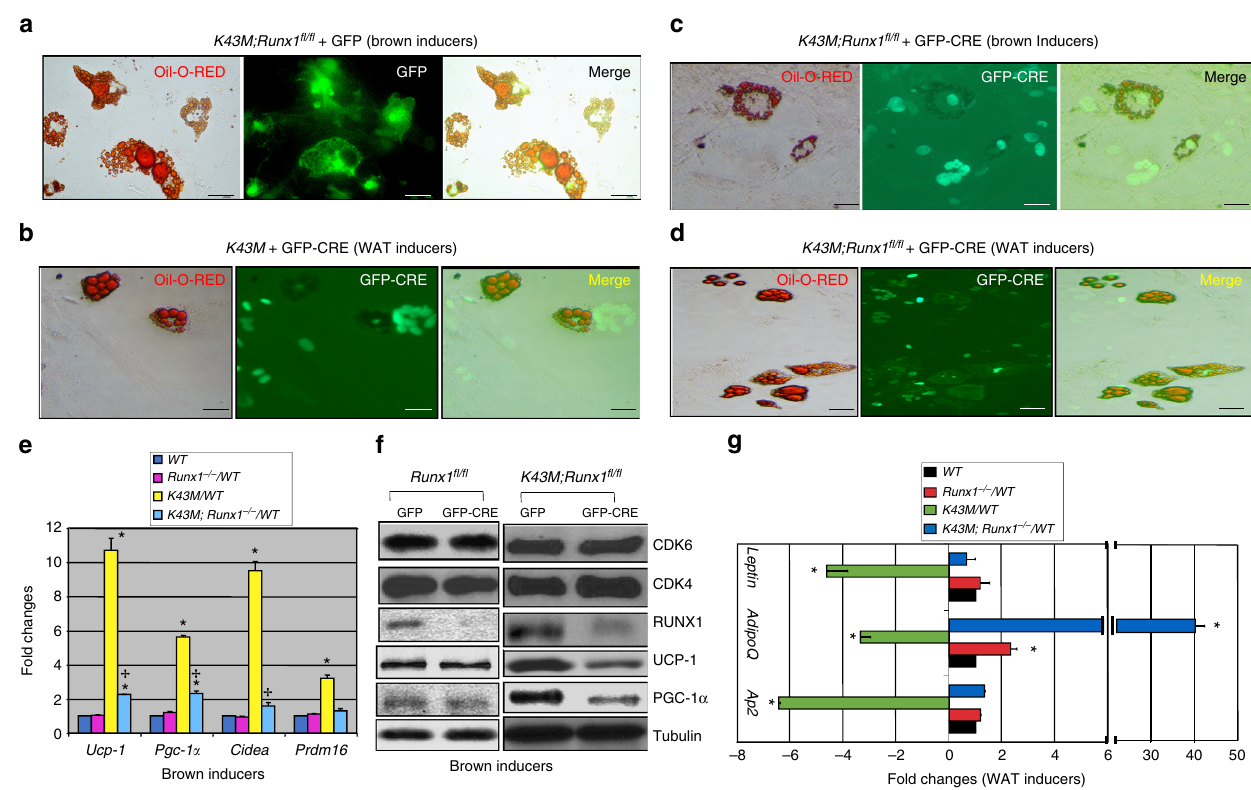
Fig. 8 Ablation of RUNX1 in K43M precursors inhibits differentiation towards brown-like adipocytes but promotes differentiation towards white adipocytes. a – d Fluorescent photomicrographs of differentiated cells from K43M cells ( K43M;Runx1 fl / fl + GFP or K43M + GFP-CRE) ( a , b ) or K43M;Runx1 − / − ( K43M; Runx1 fl / fl + GFP-CRE)(cd) in the presence of BAT ( a , c ) or WAT inducers ( b , d ). Red fl uorescence indicates the Oil Red O staining. Green fl uorescence indicates the expression of GFP/GFP-Cre. The yellow fl uorescence indicates merged images from red and green fl uorescence. Scale bar: 50 μ m. e , g Relative mRNA levels of BAT or WAT markers in differentiated cells in the presence of BAT ( e ) or WAT inducers ( g ). Data shown are the mRNA fold change of different mutants normalized to their relative WT controls, which was arbitrarily de fi ned as 1 unit, * p < 0.05, vs WT, t -test ( n = 6). ✢ p < 0.05, t - test, K43M;Runx1 − / − vs K43M . f Immunoblots of the indicated protein levels in the differentiated cells from 50 μ g of cell lysates after 7 days in the presence of BAT inducers. α -Tubulin is used as an internal loading control. See also Supplementary Figs. 8 and